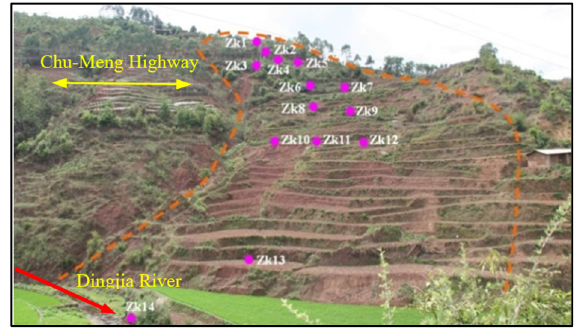
Figure 1. Slope drilling arrangement diagram.